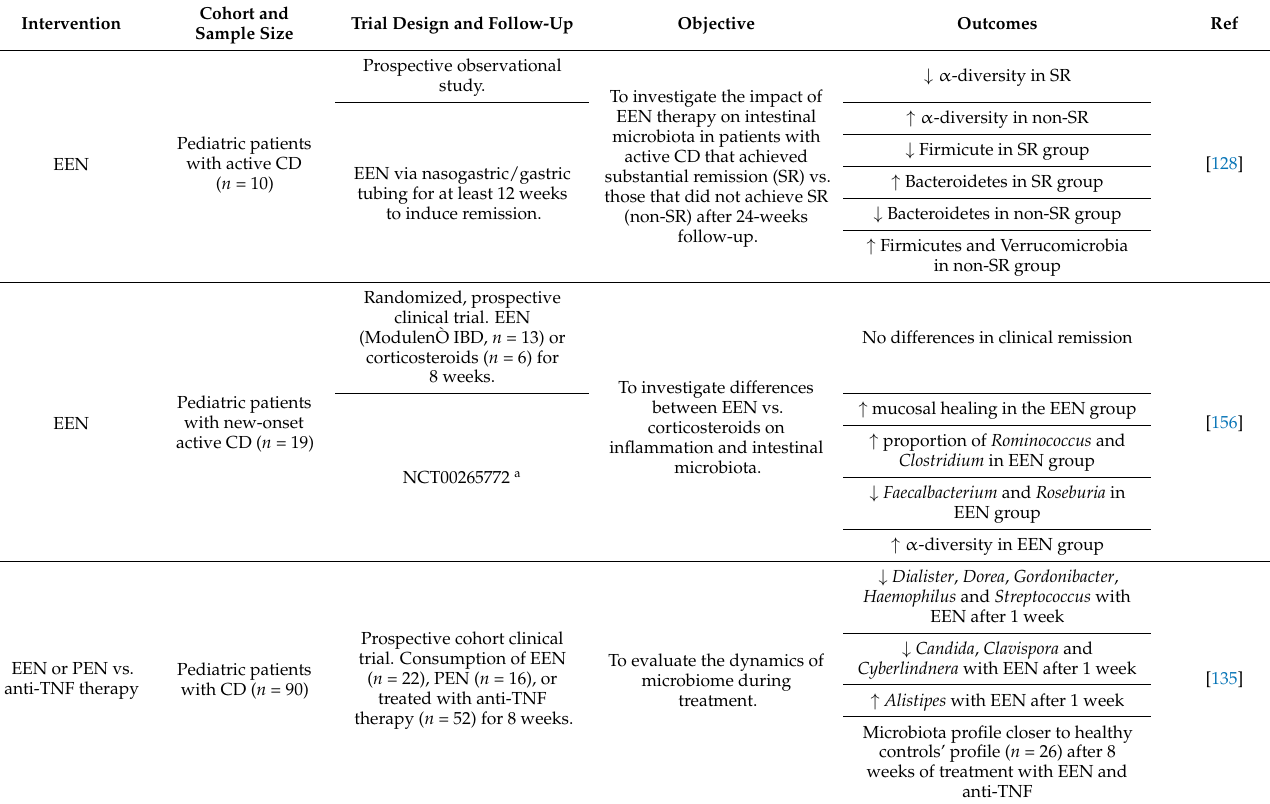
Table 1. Clinical trials with nutritional intervention in patients with